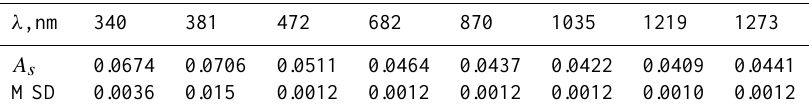
Table 3. Albedo ( A s ) of the Atlantic Ocean surface, derived from airborne observations conducted by the CAR instrument at various wavelengths ( λ) (MSD: mean square